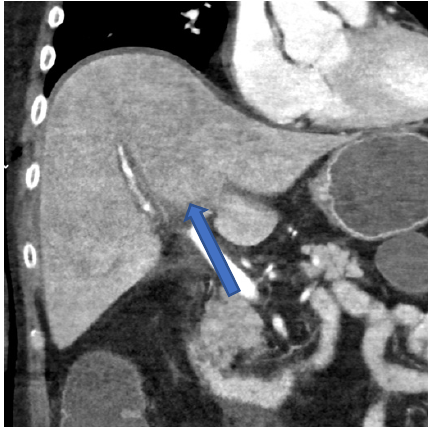
Figure 3. CT scan of the abdomen in frontal plane of case 1 showing an irregular contrasted liver parenchyma 2 days before the patient died. parenchyma 2 days before the patient